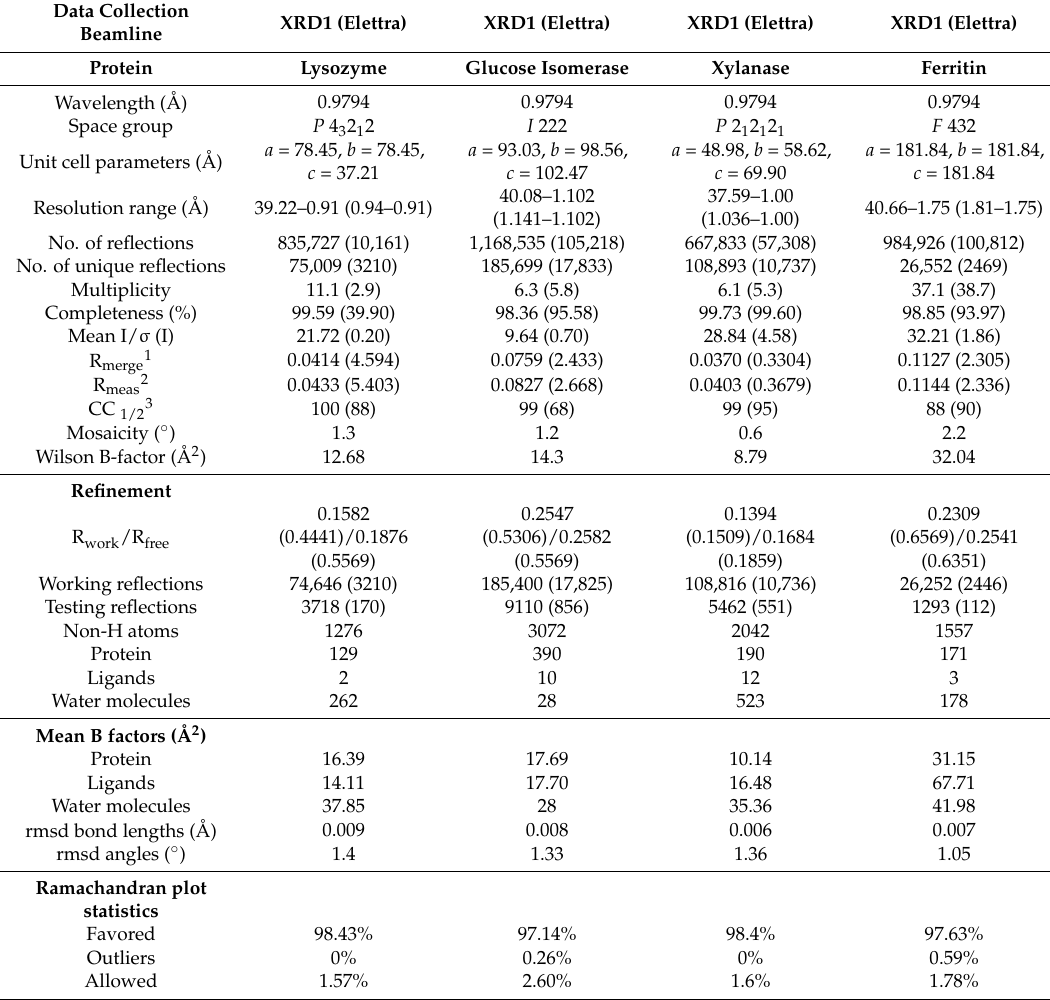
Table 2. Data collection and refinement statistics for lysozyme, glucose isomerase, xylanase and